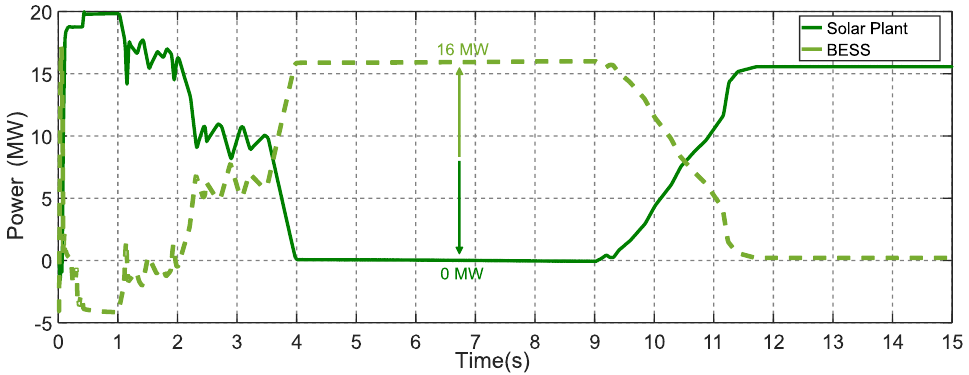
Figure 17. Solar plant and BESS curves.